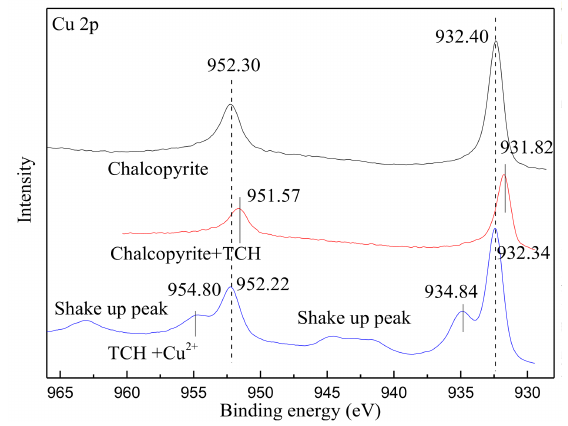
Figure 9. Spectra of TCH+Cu 2+ complexes, chalcopyrite before and after